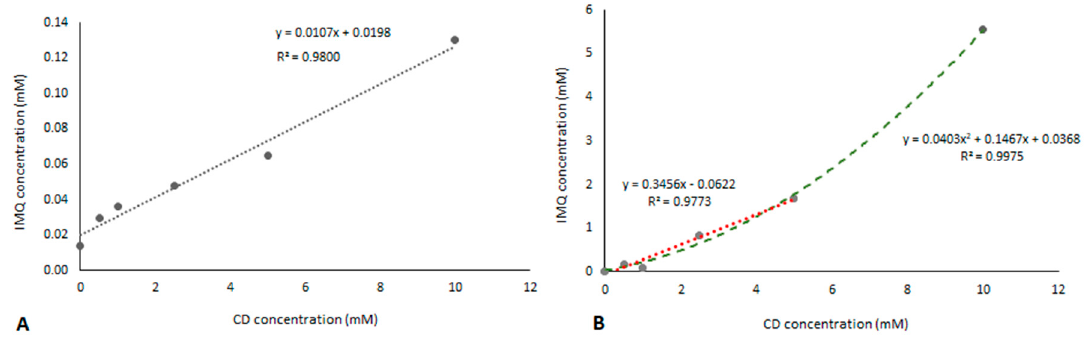
Figure 1. Phase solubility tests of the imiquimod (IMQ) inclusion complexes of (2-hydroxy)propyl β -cyclodextrin (HP β CD) ( A ) and carboxymethyl β -cyclodextrin (CM β CD) ( B ). Table 1. Stability constant (M − 1 ) and complexation efficiency (CE) of imiquimod (IMQ) inclusion complexes. Please add the full